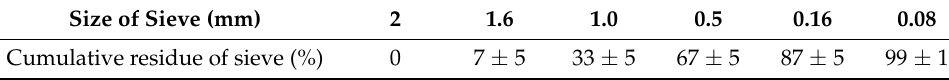
Table 3. Particle size distribution of ISO standard sand (ISO 679).